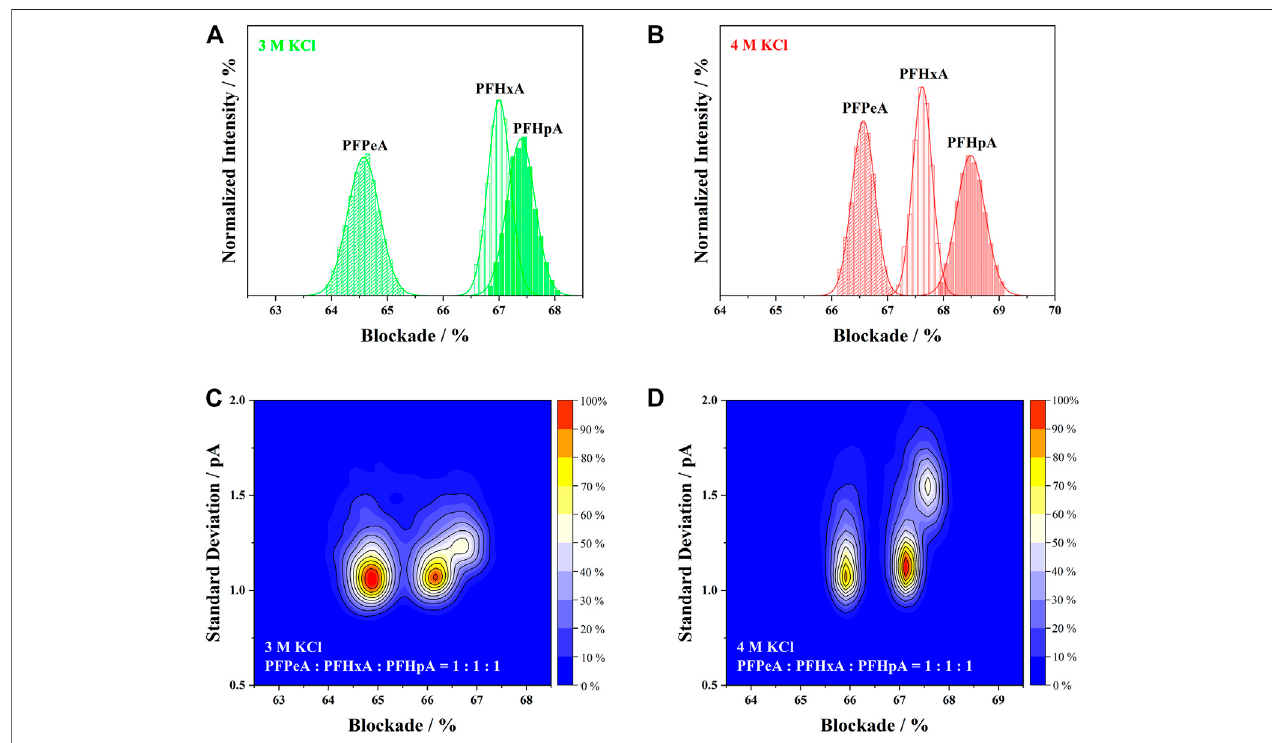
FIGURE4| OverlayofthecurrentblockadedistributionofPFPeA,PFHxAandPFHpAin (A) 3 MKCland (B) 4 MKCl.DiscriminationofPFPeA,PFHxAandPFHpA from a 1:1:1 mixed sample in (C) 3 M KCl and (D) 4 M KCl.